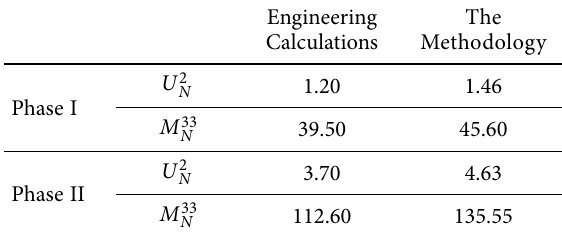
Table. The values of horizontal displacements and the values of bending moments in characteristic points of the retaining structure Engineering The Calculations Methodology